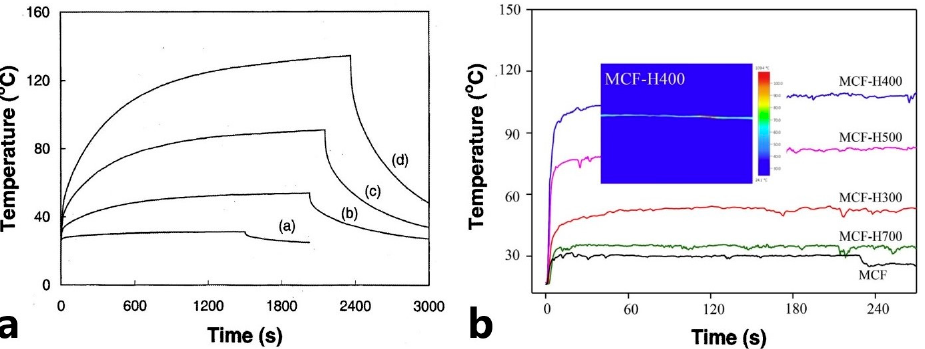
Figure 4. ( a ) Changes of T max for pure carbon fibers mat at (a) 4 V, (b) 8 V, (c) 12 V and (d) 17 V (Reprinted with permission from Elsevier, copyright 2003) [51], ( b ) changes of T max of the MCF as a function of heat treatment temperature, at 12 V (Reprinted with permission from Elsevier, copyright 2019)